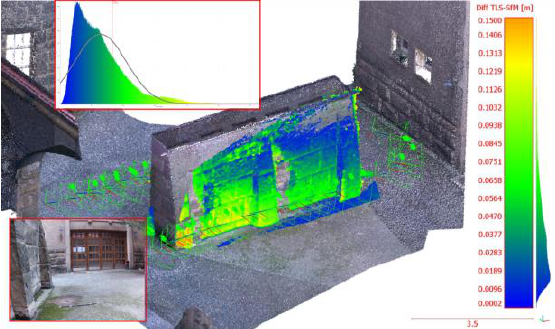
Figure 5 . Point to point difference between TLS Reference